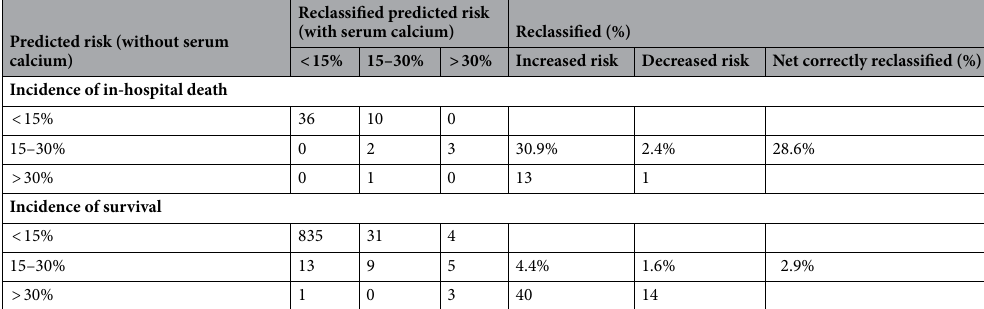
Table 4. Net reclassification improvement among patients in the highest quartile of diurnal temperature range (> 12.6 °C) after adjustment for serum calcium concentration. Net reclassification improvement (categorical) = 20.2% (95% confidence interval, 7.5–32.9; P = 0.001). Net reclassification improvement (continuous) = 57.2% (95% confidence interval, 30.0–84.3; P < 0.001).